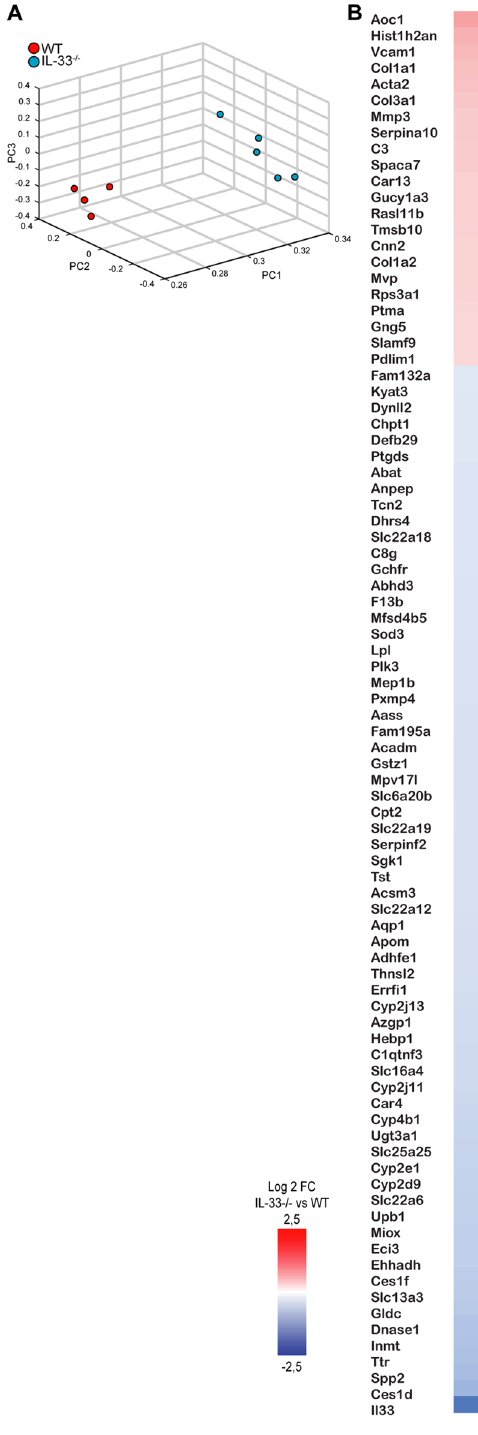
Figure 4. Summary of transcriptional differences between IL-33-deficient and wildtype mice 24 h after UUO. ( A ) The 3D scatter plot shows the distribution of samples based on a principal component analysis of 200 genes. ( B ) Heat map of top differentially expressed